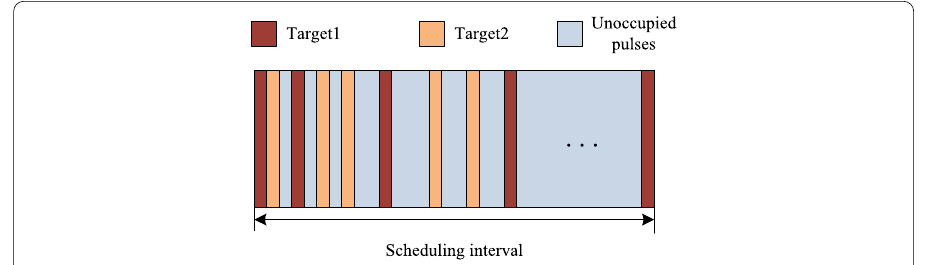
Fig. 5 The schematic diagram of sparse